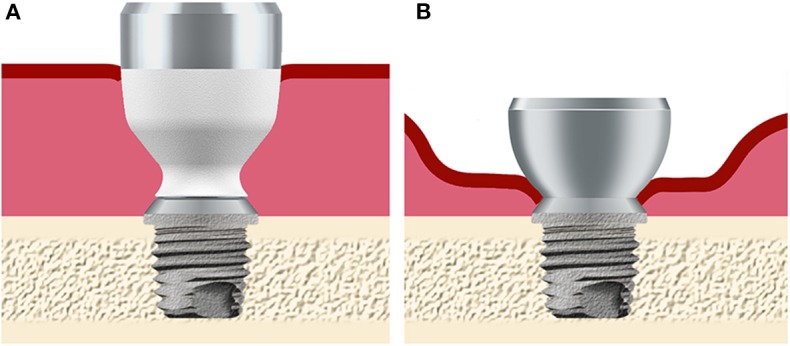
Overview of the abutment design and soft tissue status after surgery. (A) The hydroxyapatite-coated titanium abutment is placed in full thickness skin in the test group. (B) The all-titanium abutment is placed in skin where subdermal tissue has been removed using soft tissue reduction in the control group. Both abutments connect to the same implant fixture, which is placed in the skull bone behind the ear.